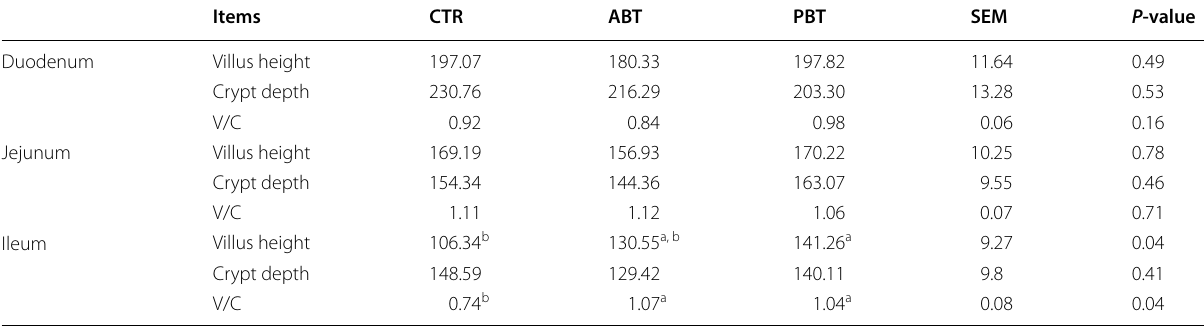
Table 5 Effects of dietary B. subtilis supplementation on intestinal morphology of piglets